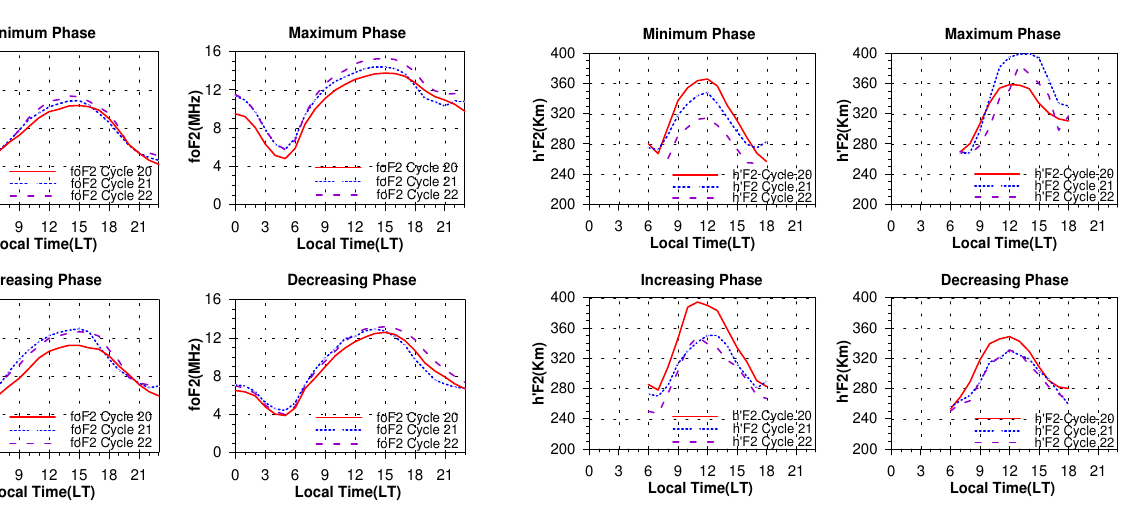
Fig. 8. Diurnal variation of the critical frequency fo F2 during min- imum phase (left top panel), increasing phase (left bottom panel), maximum phase (right top panel) and decreasing phase (right bot- tom panel) for sunspot cycle 20 (red curves), sunspot cycle 21 (blue curves) and sunspot cycle 22 (violet curves). Figure 9